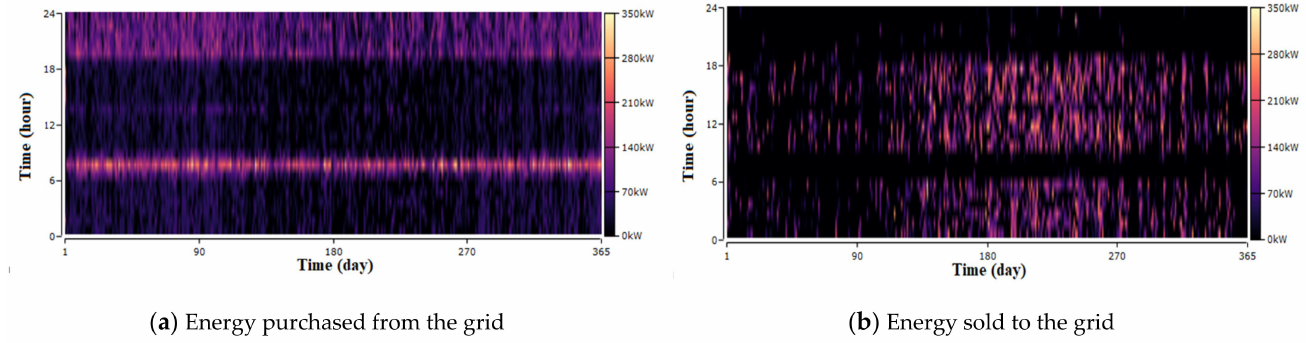
Figure 14. Putrajaya, FH-5000 wind turbine case.